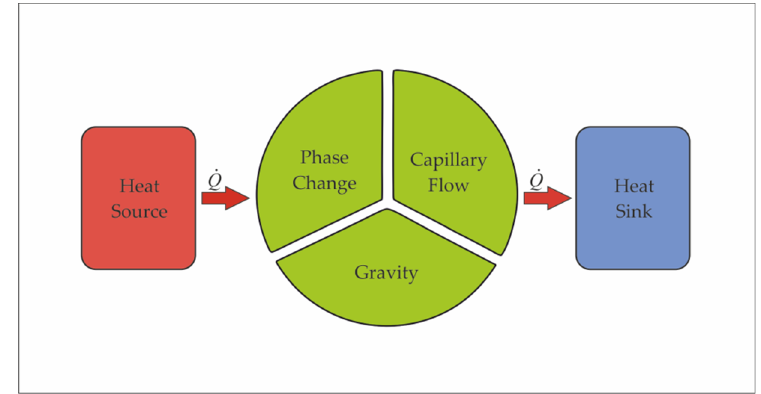
Figure 1. General diagram of a passive heat exchanger.